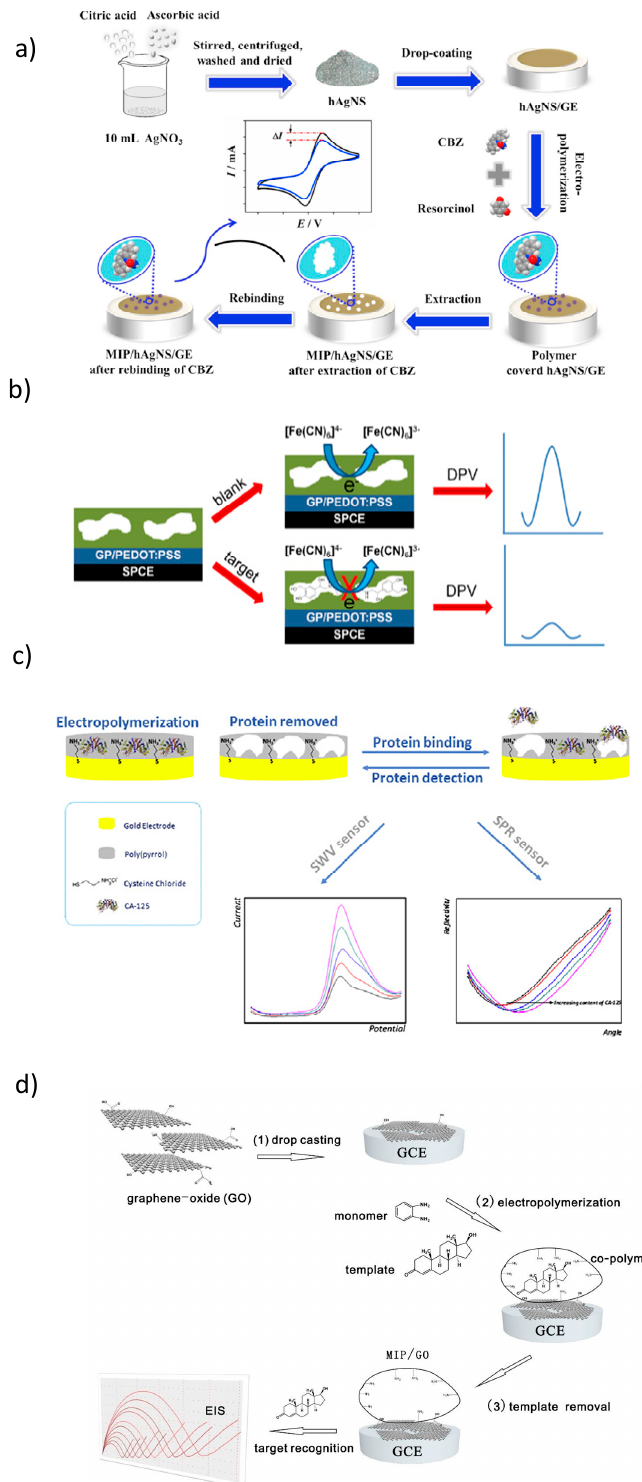
Figure 8. ( a ) Preparation of a carbamazepine MIP, reprinted by permission from [126]; ( b ) schematic representation of salbutamol MIP preparation and DPVs showing salbutamol binding to the MIP, reprinted by permission from [119]; ( c ) CA-125 MIP preparation by electropolymerization and SWV- and SPR-based measurements, reprinted by permission from [120] and ( d ) testosterone MIP preparation and EIS-based determination of testosterone, reprinted by permission from [121].